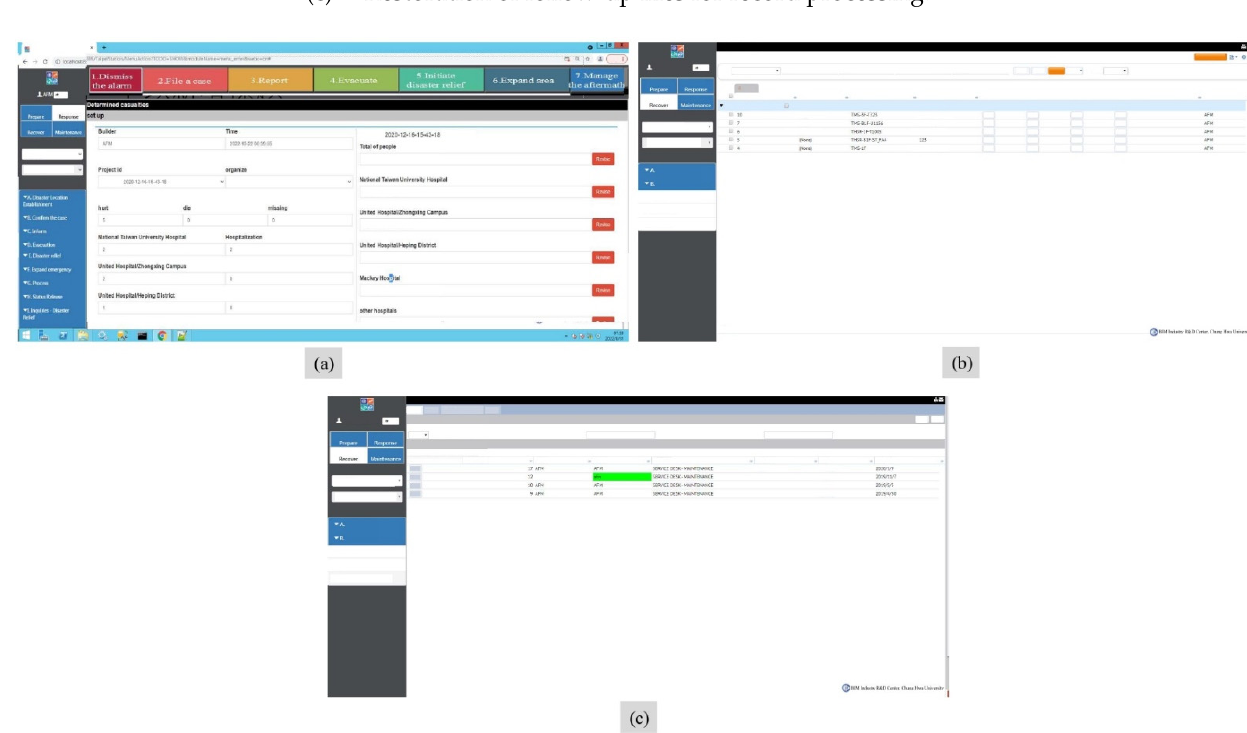
Figure 14. Post management: Recovery of follow-up inquiry. (Source: Research Data). ( a ) Generate number of casualties; ( b ) Follow up with incident control center; ( c ) Recover follow-up inquiry.